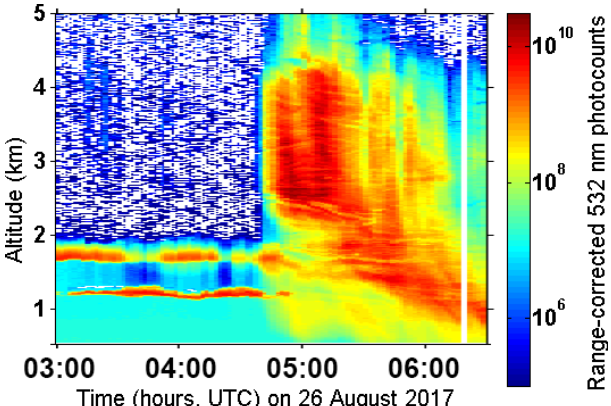
Figure C1. A summer example of fine-scale structure in clouds at Eureka. Plot of 532nm range-scaled photocounts from 26 August 2017. The layers are most visible after 05:00UTC. The measure- ment was stopped due to rain at